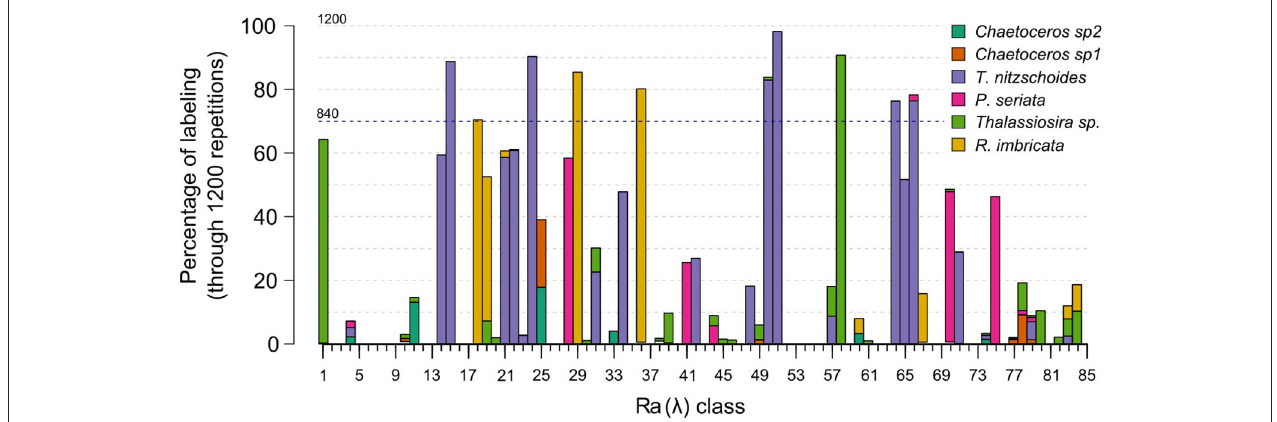
FIGURE 4 | Percentage of Ra( λ ) classes labeled with diatom assemblage(s) during the repetitive procedure of labeling including 1,200 random subsets of calibration. X axis represents the Ra( λ ) classes identified by a number (1–85) and Y axis represents the rate of labeling of these Ra( λ ) for the 1,200 random calibration-subsets. Each bar corresponds to the percentage of labeling of a specific Ra( λ ) class (height) and associated with a specific in-situ assemblages indicated by the colors. See sections 2.4.3 and 2.4.4 for method of labeling and repetitive procedure. Blue dotted line represents the 70% threshold which define a robust labeling (section 3.2).